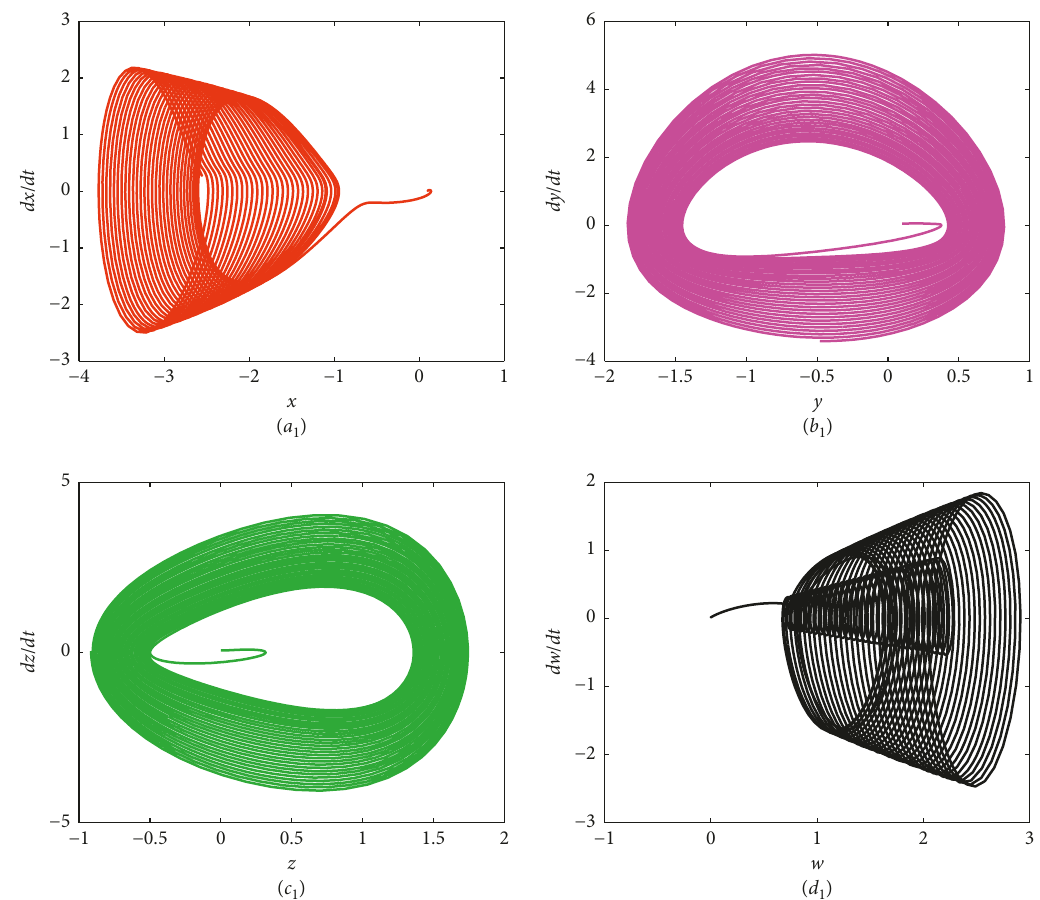
Figure 11: Phase portraits of Experiment 2 with a � 0 . 1 , t � 100: ( a ) phase diagram of w . ( d 1